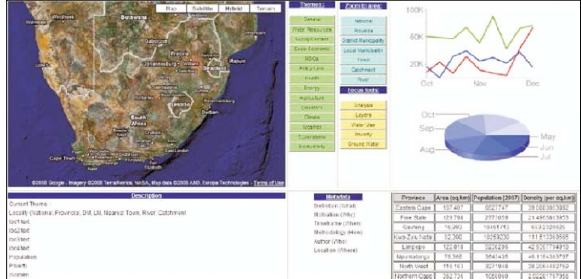
Figure 3. IWRDSS Dashboard (Integrated Water Resource Decision Support System) with Google Earth map, pie chart, graph and table (Craigie, 2008).